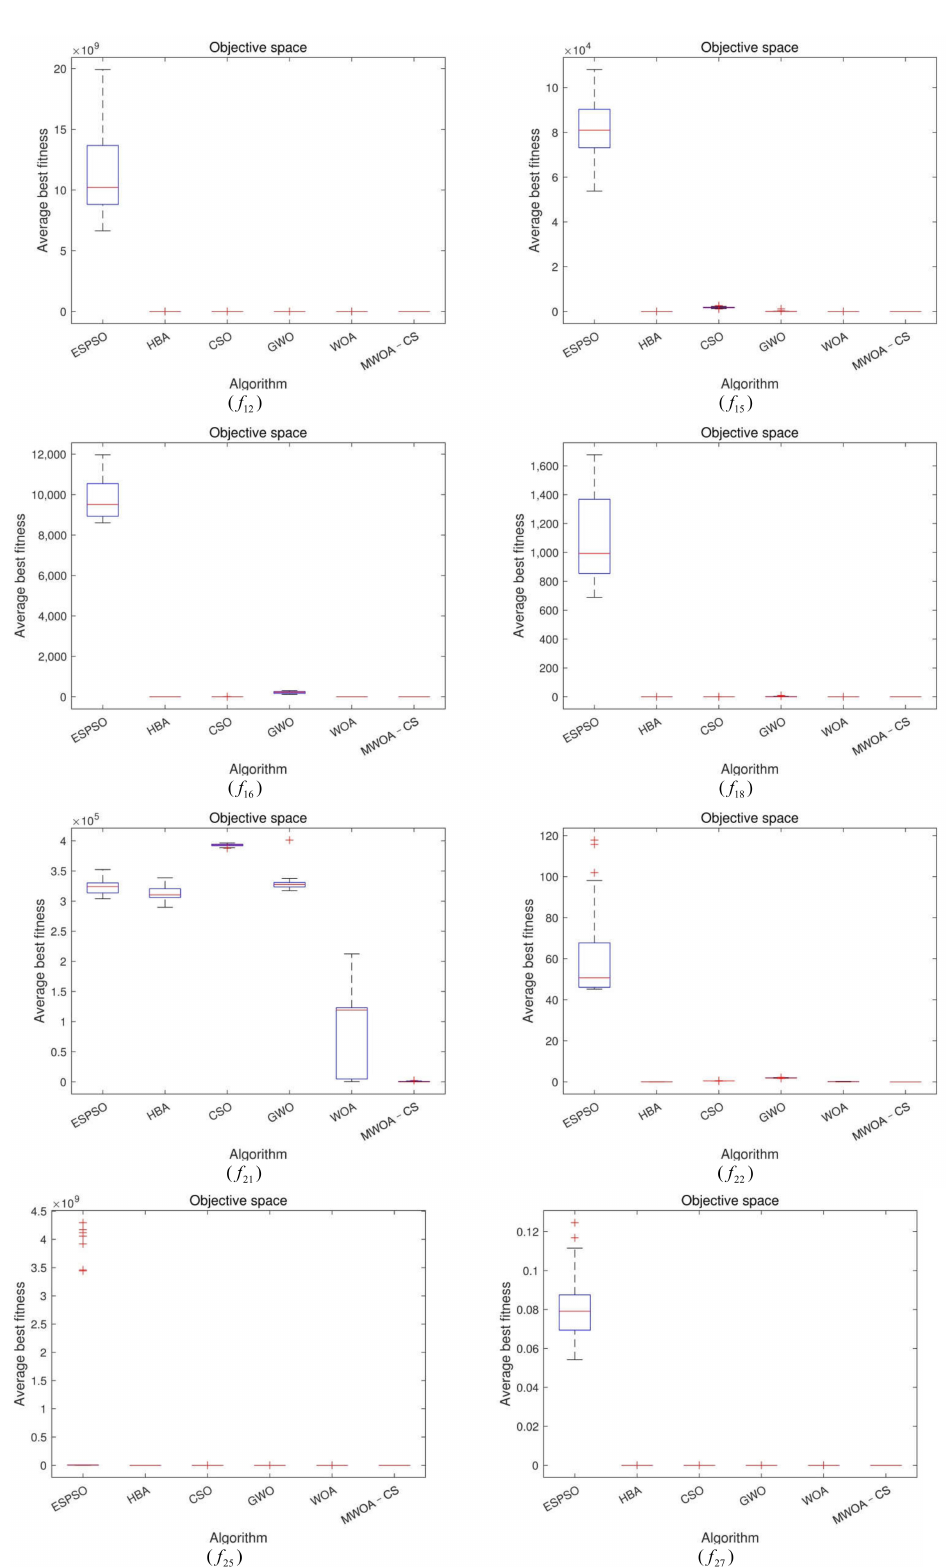
Figure 5. Box-plot of some selected unimodal /multimodal test problems with 1000